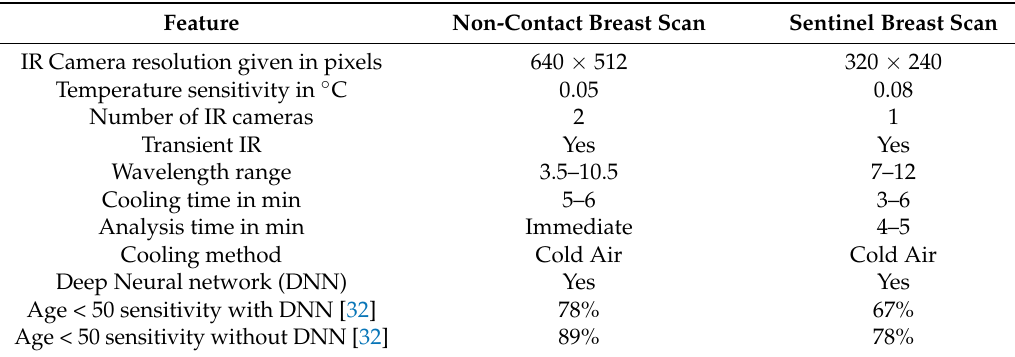
Table 1. Difference between the Sentinel Breast Scan and No Touch Breast Scan.